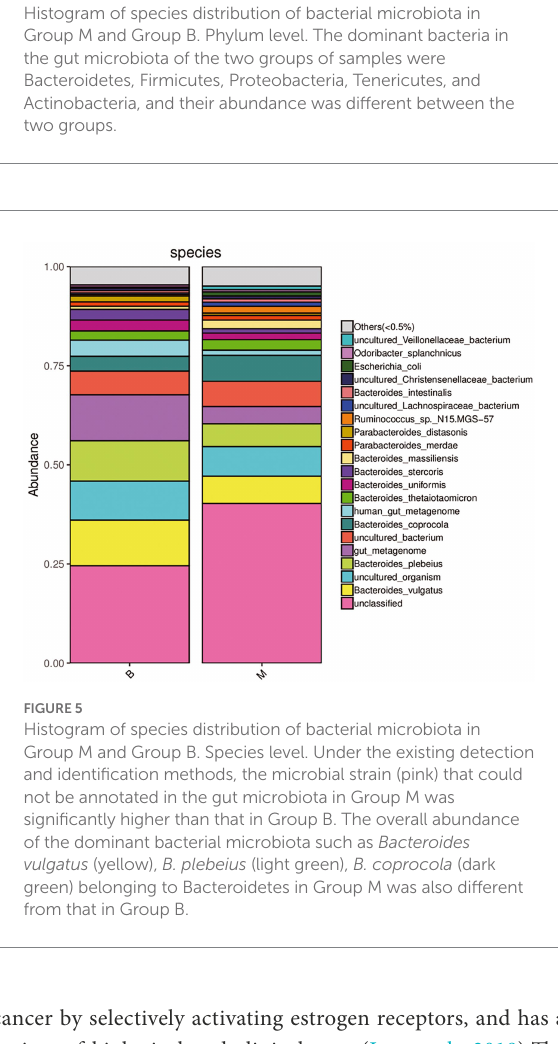
FIGURE 4 Histogram of species distribution of bacterial microbiota in Group M and Group B. Phylum level. The dominant bacteria in the gut microbiota of the two groups of samples were Bacteroidetes, Firmicutes, Proteobacteria, Tenericutes, and Actinobacteria, and their abundance was different between the two groups.